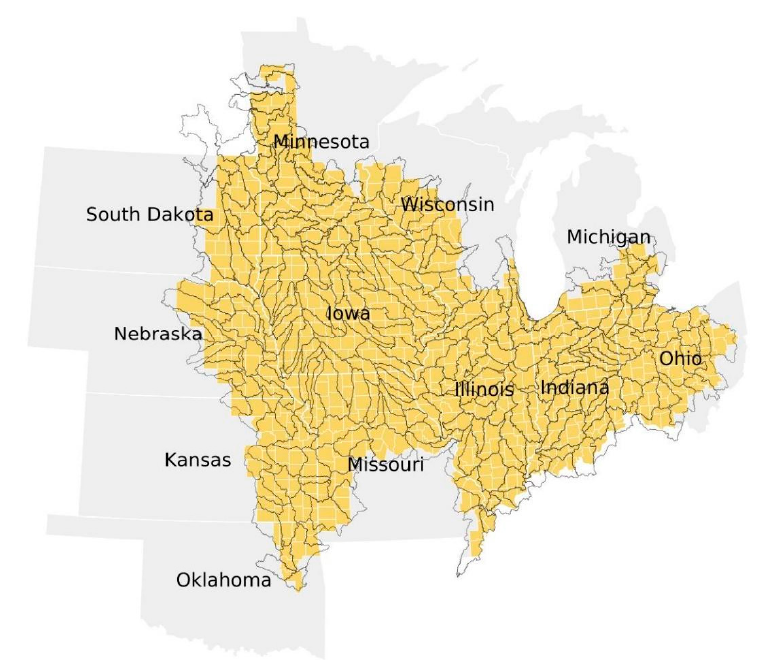
Figure 1. Mapping by the Operational Tillage Information System (OpTIS) was done on 645 counties (yellow), and 2748-digit hydrologic unit code (HUC 8) watersheds (black outline). Watersheds within the Land Resources Region-M only were selected, this area covers 12 states in the Corn